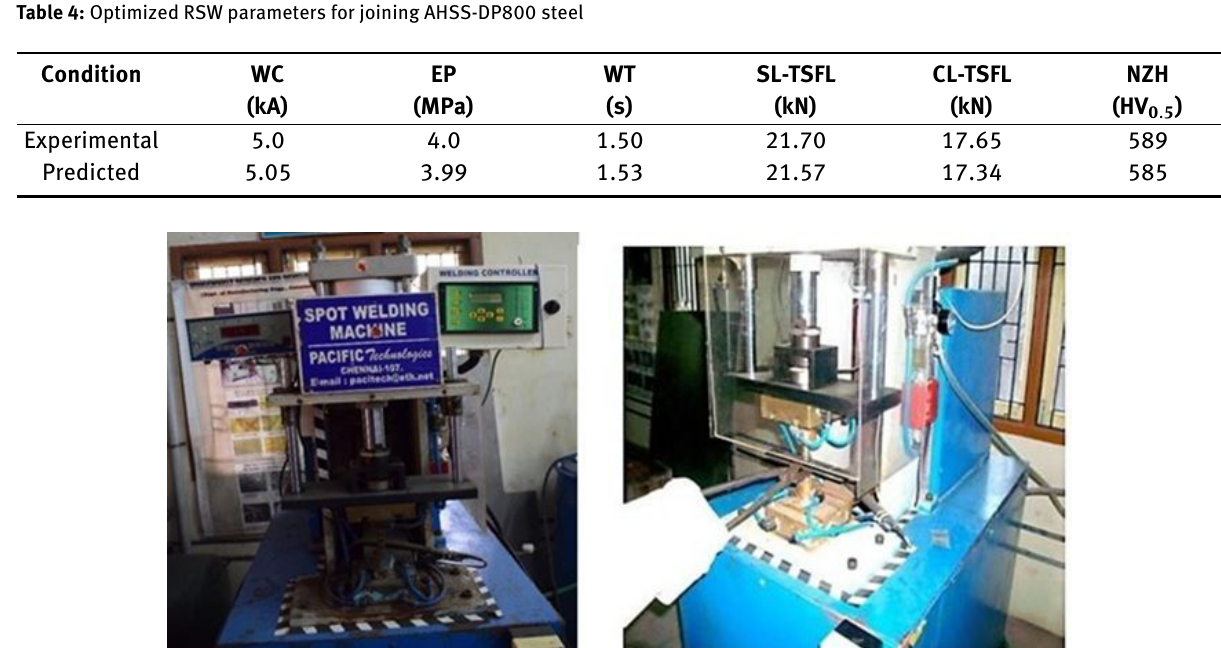
Figure 1: Photograph of RSW machine employed in this investigation